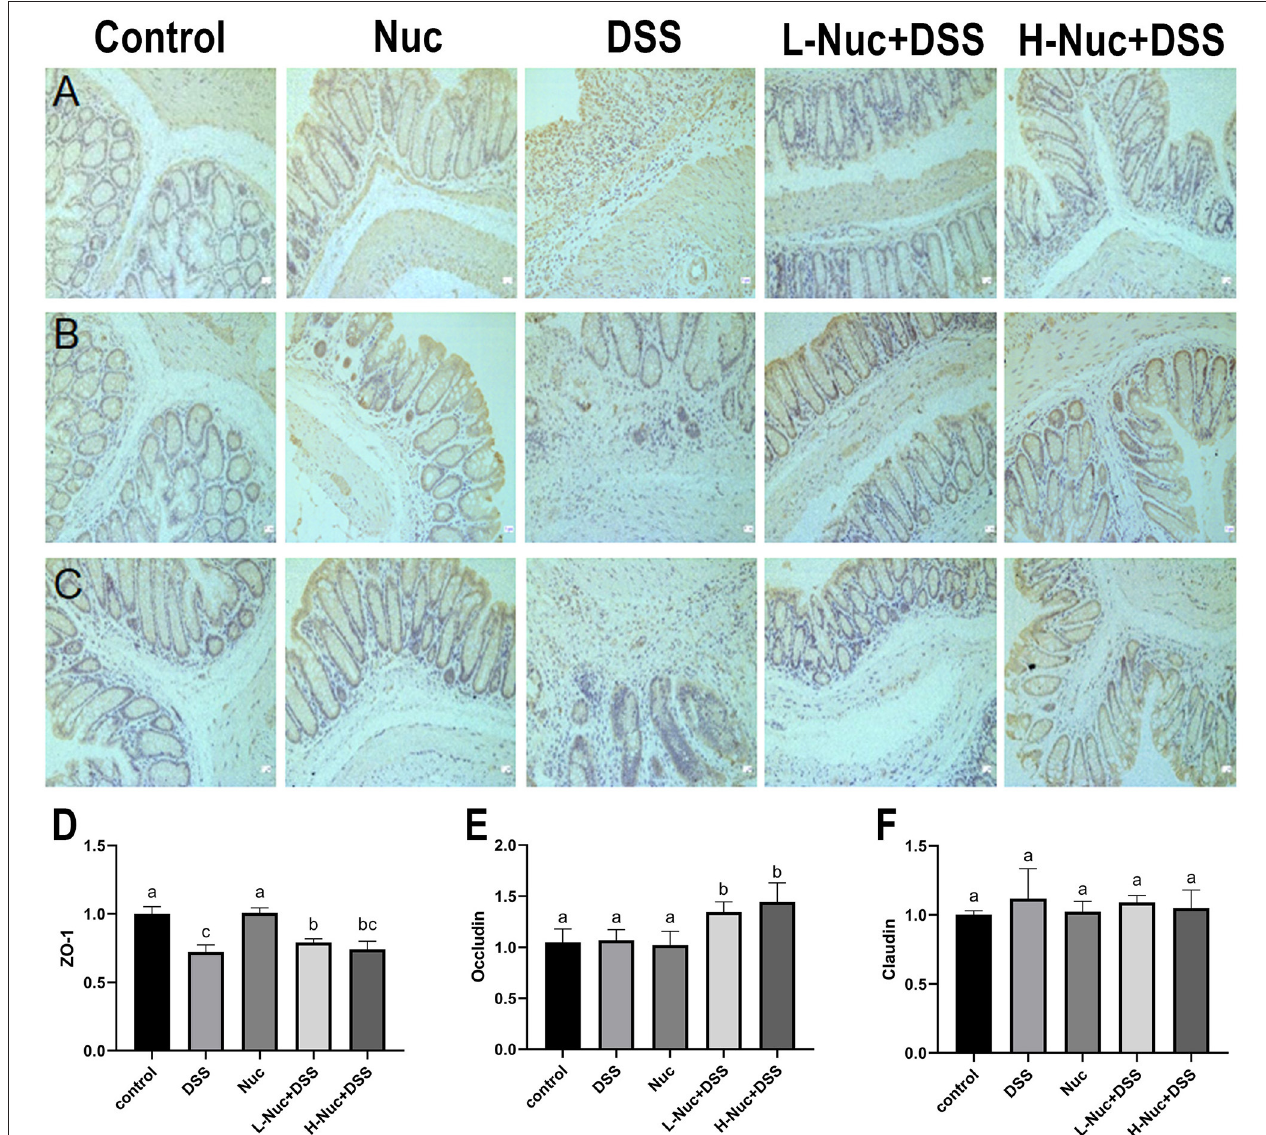
FIGURE 8 | Nuciferine repaired intestinal mucosal damage. (A) Representative immunohisto chemical (IHC) staining of ZO-1. (B) IHC staining of occludin. (C) IHC analysis of claudin-1 in colon tissues. (D) Immunohistochemical analysis of ZO-1. (E) Immunohistochemical analysis of occludin. (F) Immunohistochemical analysis of claudin-1. The dataare expressed as the mean ± S.D ( n = 6). Significant differences were considered at P < 0.05. a − c Bars without the same superscripts differ significantly ( P <